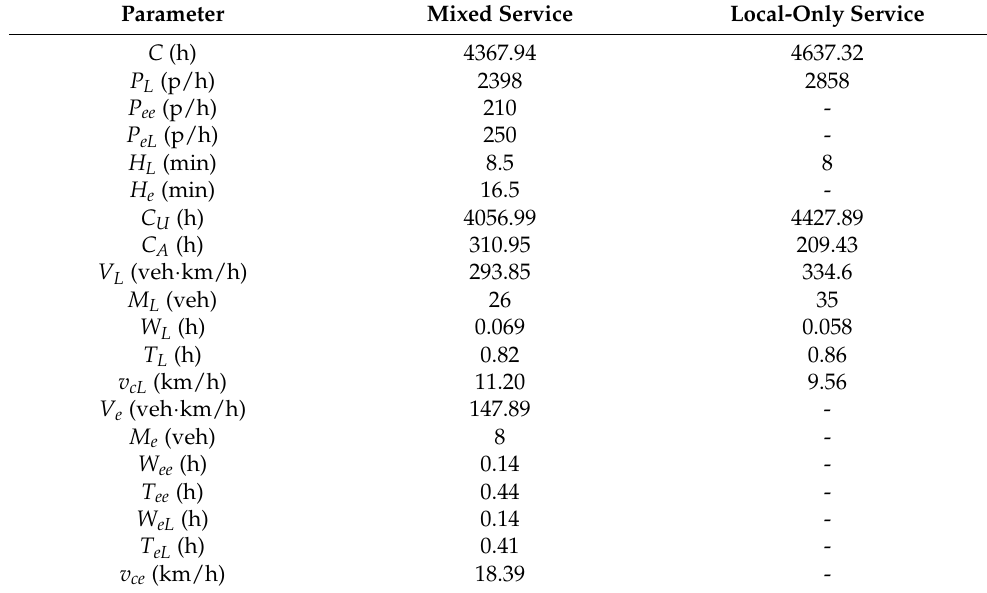
Table 4. The comparison